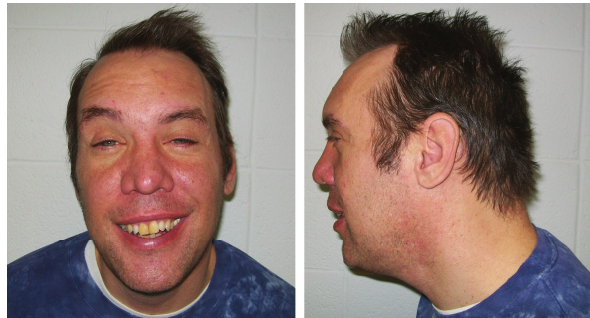
Figure 1: Frontal and profile facial views of the proband at 41 years of